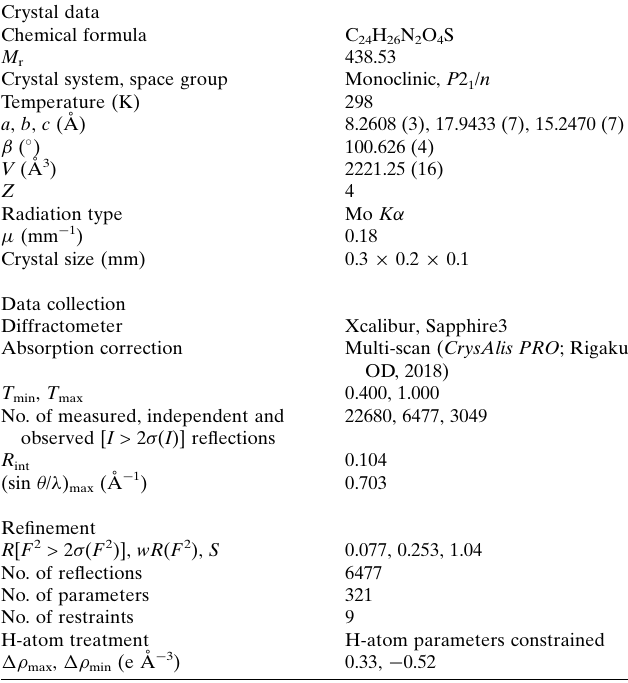
Table 3 Experimental details. Crystal data Chemical